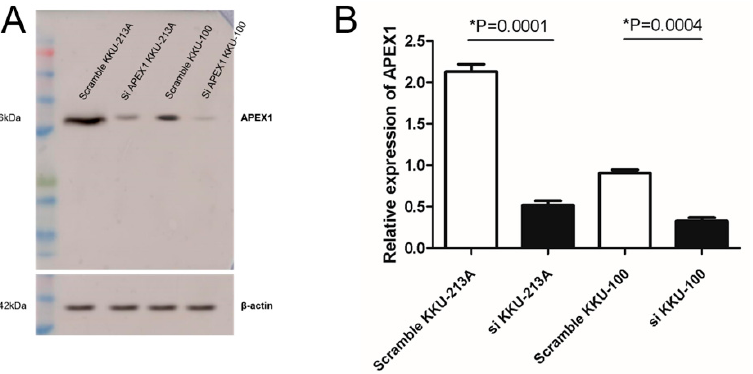
Figure 2. Expression of APEX1 protein in APEX1 gene-silenced, compared with scramble-control, CCA cell lines. ( A ) Western blot analysis showed the suppression of APEX1 protein expression after gene silencing. β -actin was used as a control for loading protein. ( B ) Relative expression of APEX1 for gene silencing.